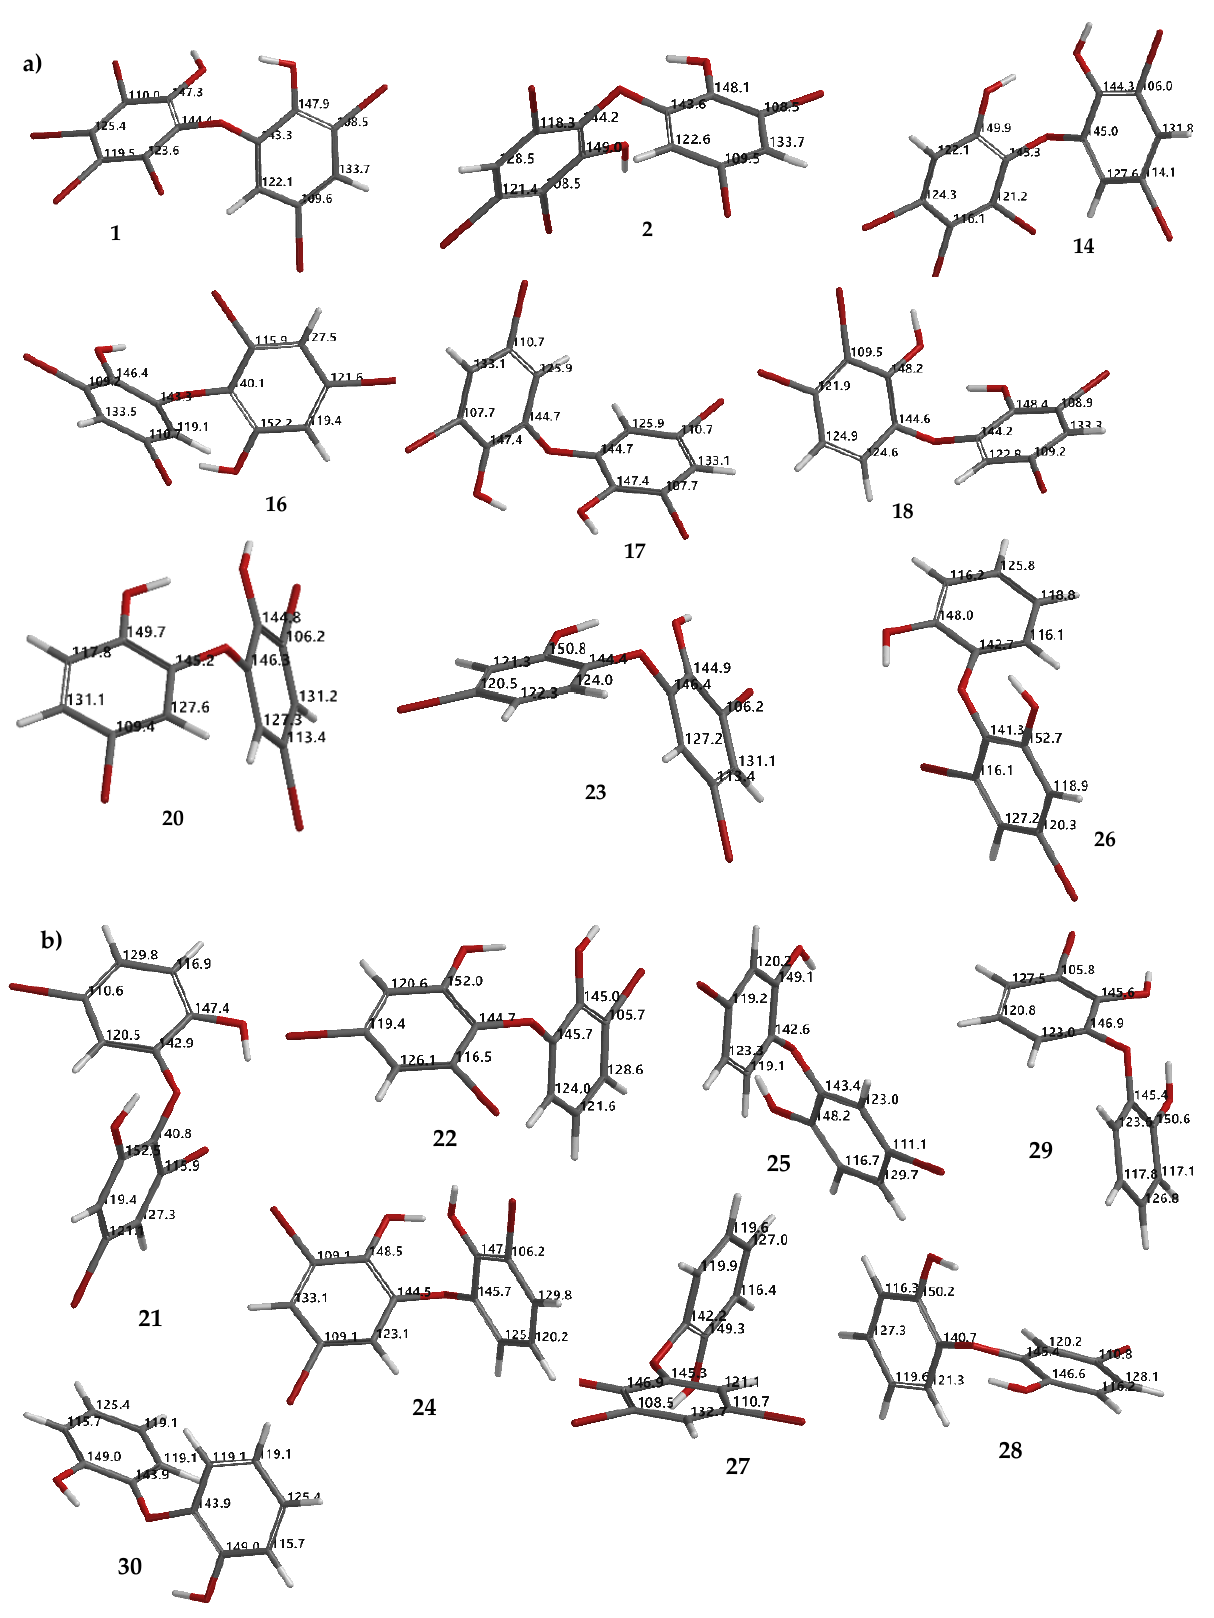
Figure 8. Theoretical 13 C NMR chemical shifts of debromination products ( 1 , 2 , 14 , 16 – 18 , 20 , 23, 26 ) ( a ) and hypothetical molecules ( 21 , 22 , 24 , 25 , 27 – 30 ) calculated using the NMR chemical shift calculation protocol ( b ).